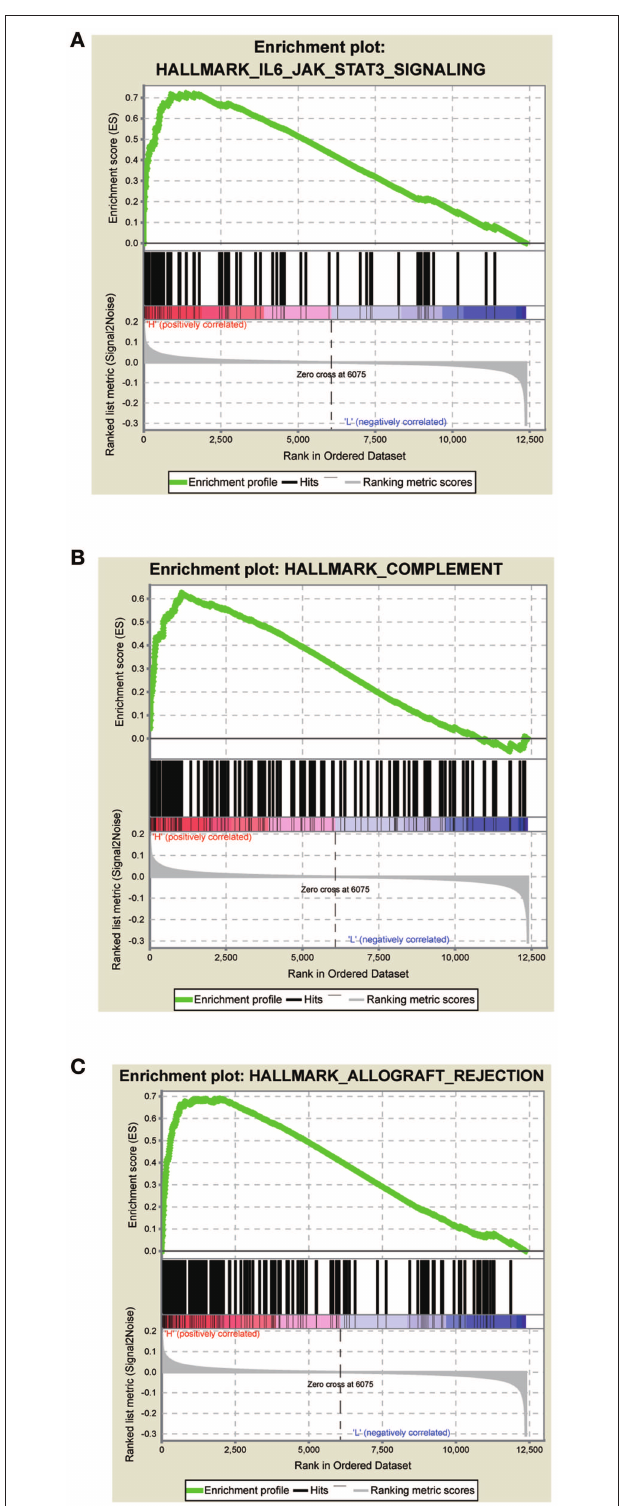
FIGURE 4 | Score correlated enrichment gene analysis with GSEA. (A) Hallmark IL6 JAK SATA3 SIGNALING ( P = 0.004; FDR = 0.104; ES = 0.72); (B) HALLMARK COMPLEMENT ( P = 0.002; FDR = 0.110; ES = 0.62); (C) HALLMARK ALLOGRAFT REJECTION ( P = 0.031; FDR = 0.180; ES =